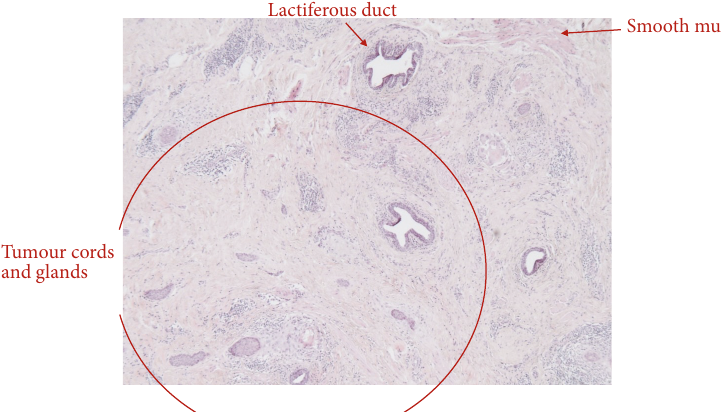
Figure 5: Micrograph of the tumour. Tumour cords and glands surrounding lactiferous ducts and smooth muscle.